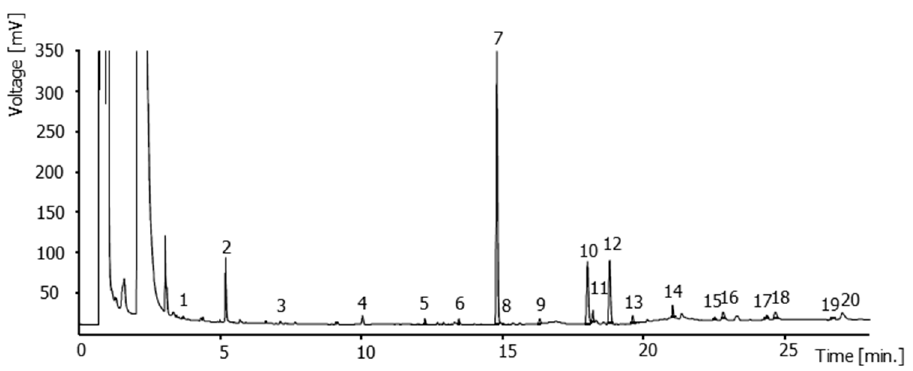
Figure 1. Individual profile of fatty acids of Kennebec T1: 1- C6:0; 2- C8:0; 3- C10:0; 4- C12:0; 5- C14:0; 6- C15:0; 7- C16:0; 8- C16:1; 9- C17:0; 10- C18:0; 11- C18:1n9c; 12- C18:2n6c; 13- C18:3n3; 14- C20:0; 15- C20:3n3+C21:0; 16- C20:5n3; 17- C22:0; 18- C22:1n9; 19- C23:0; 20- C24:0.